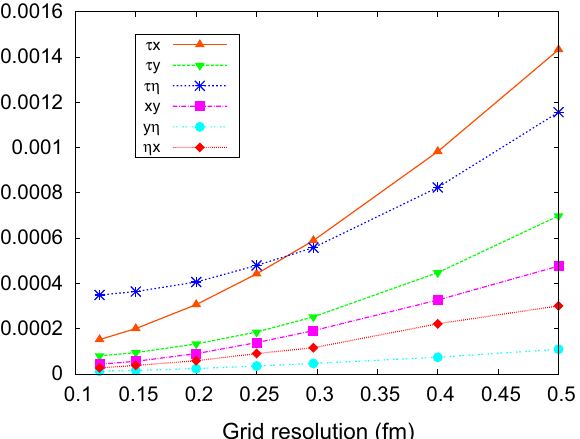
Fig. 2 Mean of the absolute value of T-vorticity components, divided by T 2 , at the freeze-out as a function of the grid resolution The original article can be found online at https://doi.org/10.1140/ epjc/s10052-015-3624-1.